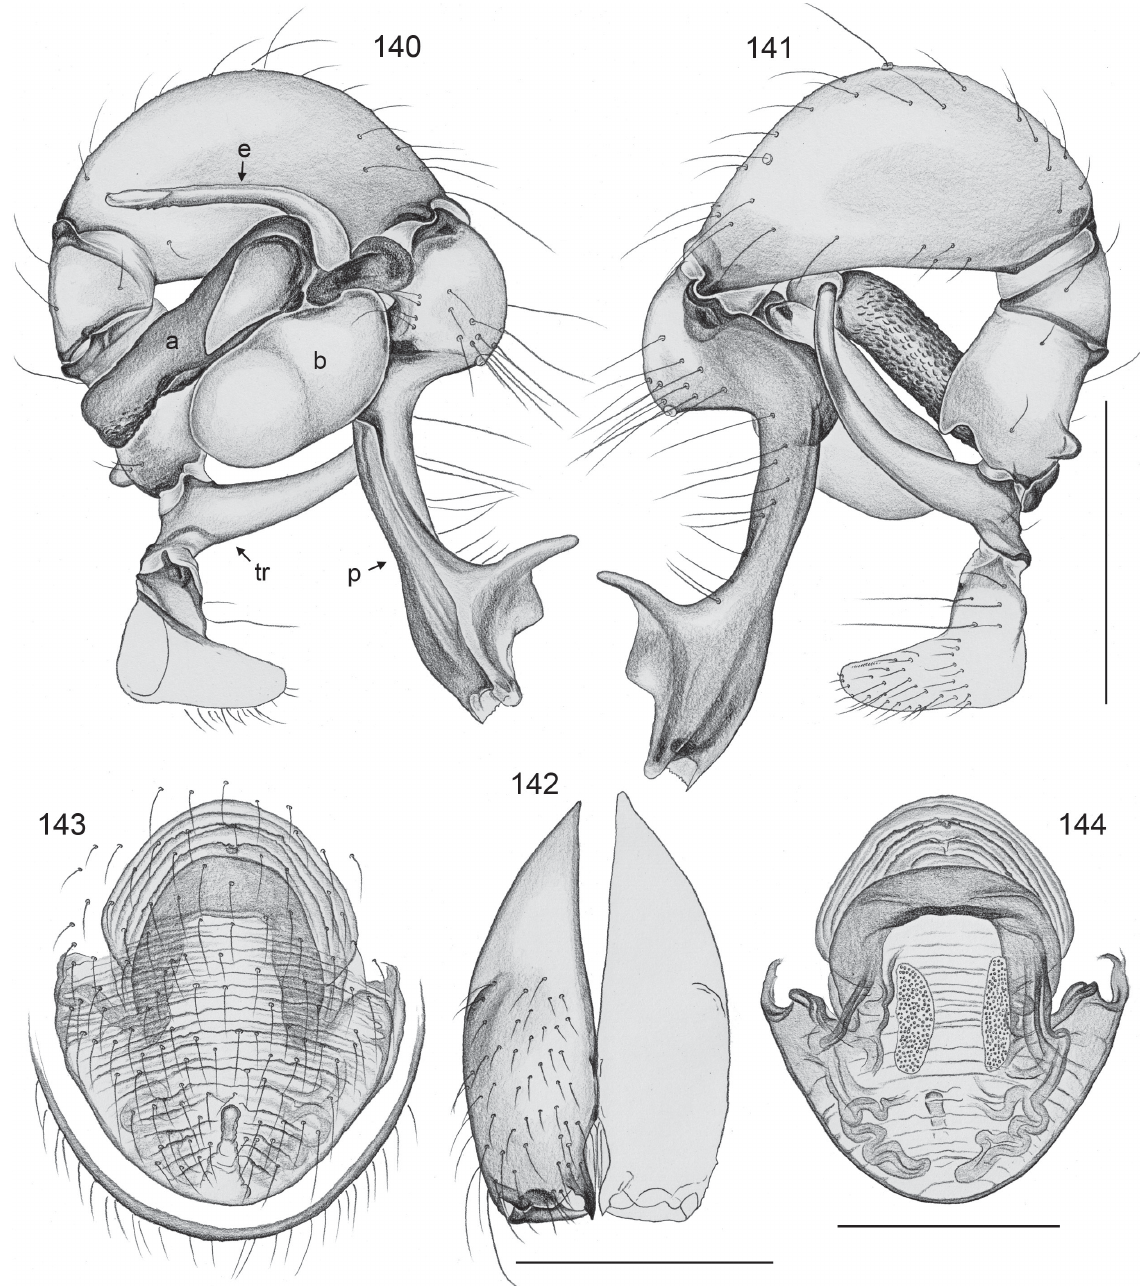
Figs 140–144. Pholcus domingo Huber sp. nov. (ZFMK, Ar 15720–21). 140–141 . Left male palp, prolateral and retrolateral views. 142 . Male chelicerae, frontal view. 143–144 . Cleared female genitalia, ventral and dorsal views. Scale bars: 140–141 = 0.5 mm; 142–144 = 0.3